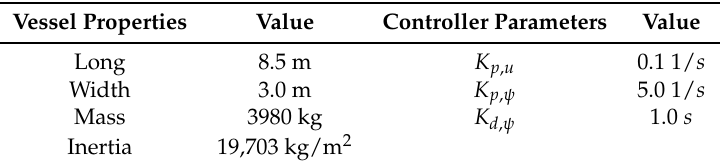
Table 1. Vessel properties and controller parameters.